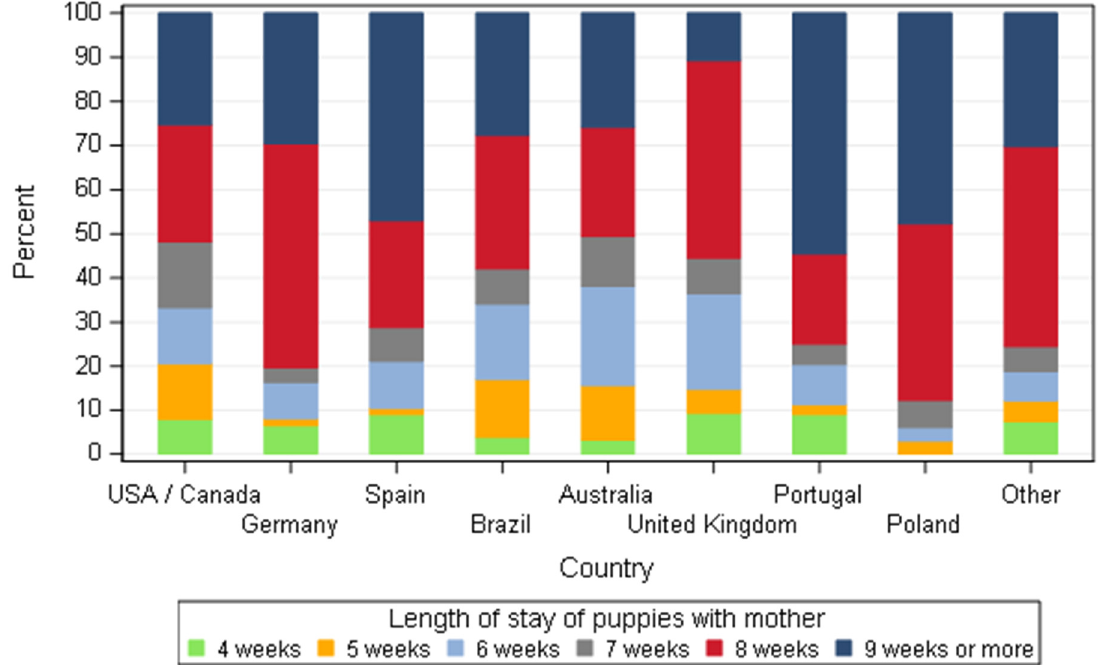
Figure 18. Duration in weeks that puppies stay with the dam according to dog breeders by country—all responders ( n = 668).